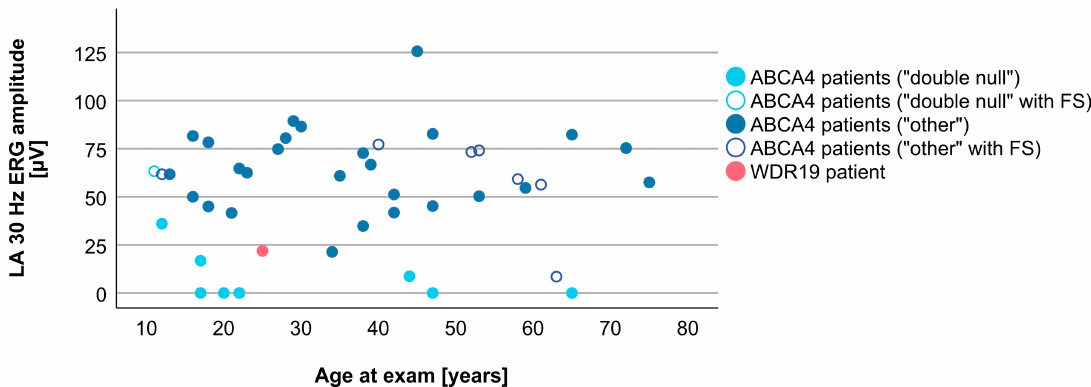
Figure 8. Comparison of DA 0.01 ERG b-wave amplitude (representing rod system function) between WDR19 patient (red), double null ABCA4 patients (light blue) and ABCA4 patients with other genotypes (dark blue). Foveal sparing patients are marked with empty circles.